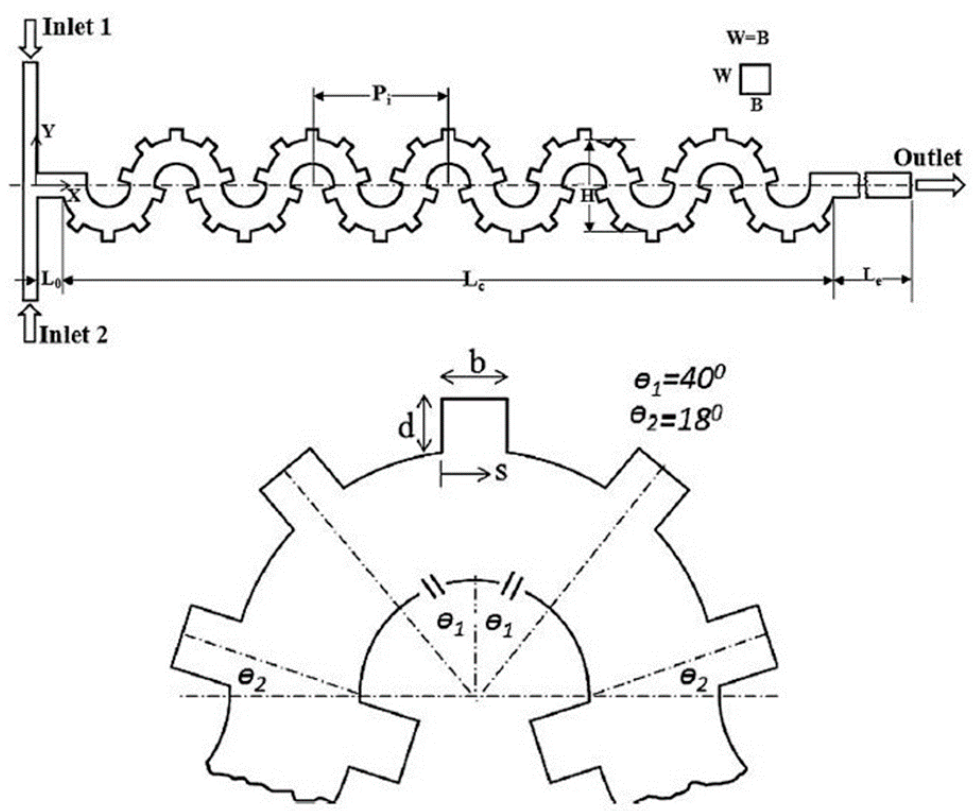
Figure 1. Curved micromixer: M ‐ 1 (no. of mixing units used: 8). Reproduced with permission from [40].